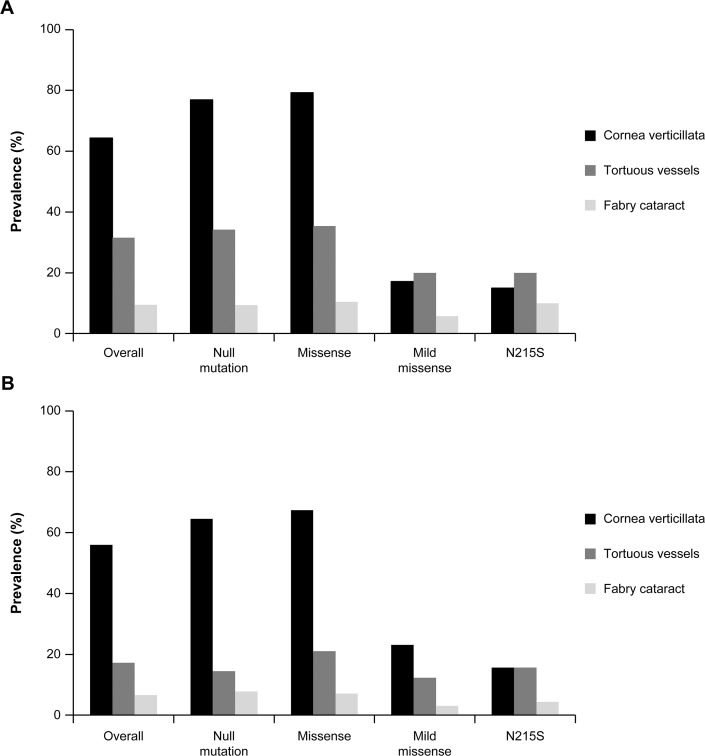
Prevalence of eye findings by type of mutation.Prevalence of eye findings overall (among those patients with mutation information available) and by type of mutation in adult (A) male and (B) female patients.